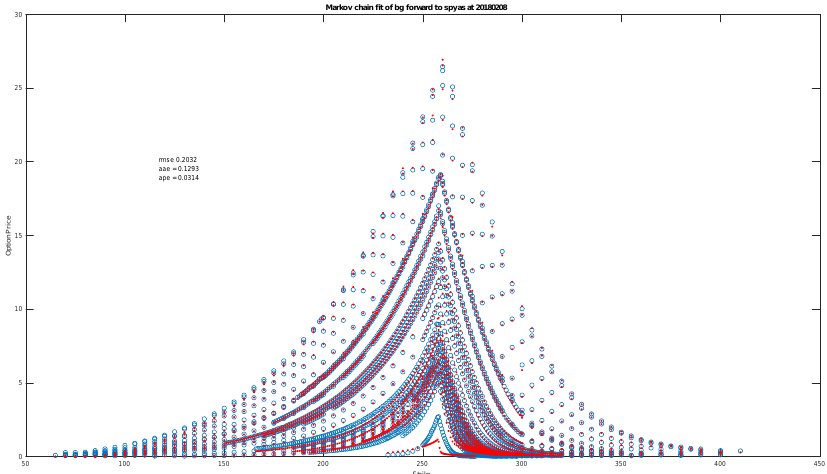
Figure 6. Fit of bgforward to SPY as at 8 February 2018 using Markov chain approximations. Figure 6: Fit of bgforward to SPY as at February 8, 2018 using Markov chain The calibrated parameter matrix was as follows Table 2. The four columns present the values for approximations. b p , c p , b n , and c n . Table 2. Forward Parameter Forward Parameter Values